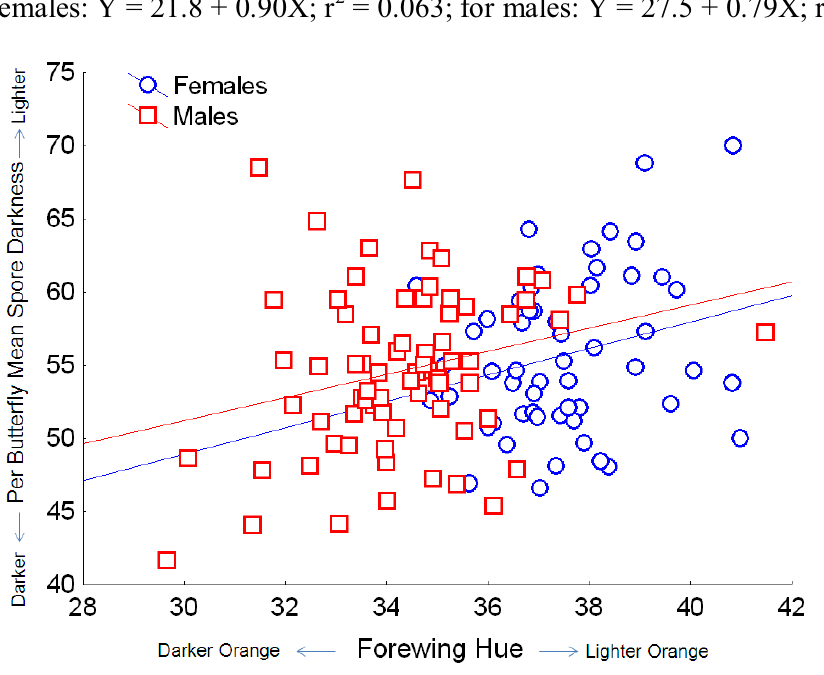
spore load) and 10